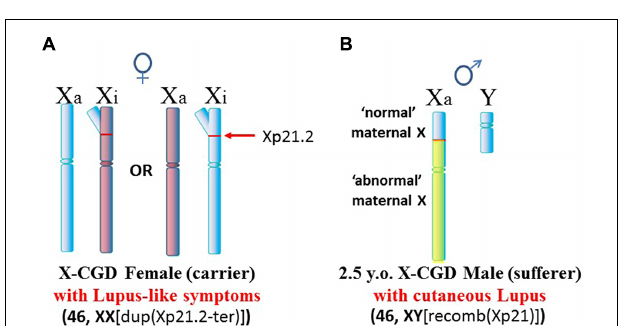
FIGURE 5 | X-CGD and lupus. (A) An X-CGD female with duplication of chromatin from Xp21.2 to the distal end of the Xp suffered from lupus-like symptoms (Brandrup etal., 1981).The additional Xp gene copies would present difficulties in maintaining proper X inactivation. (B) There are only three reports of lupus-like symptoms in X-CGD males since they succumb at an early age whereas lupus typically appears later in early adulthood. Only one of these cases had data regarding chromosome abnormalities (Ortiz-Romero etal., 1997). In this case, the patient exhibited cutaneous lupus.The X chromosome was a crossover at Xp21.2 between the mother’s normal and abnormal X chromosomes.Whether this X abnormality contributed to the lupus-like symptoms, and how it might contribute, are not